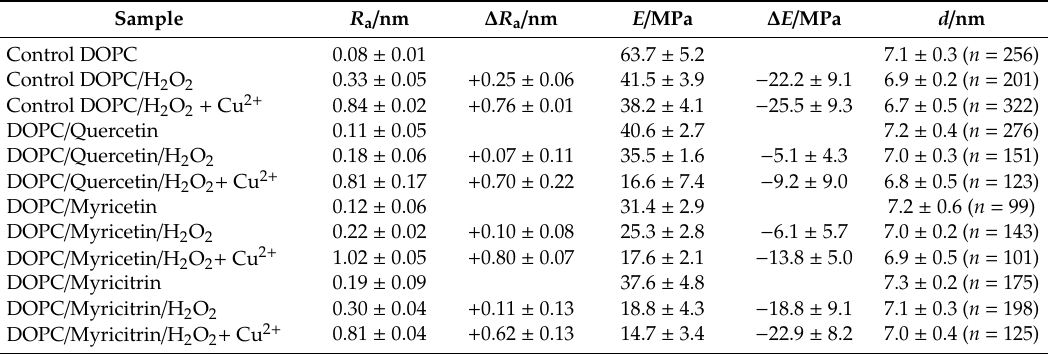
Table 5. The e ff ect of induced lipid peroxidation on the roughness ( R a ), bilayer thickness ( d ) and the Young Modulus ( E ) of the model DOPC SLB ( n =